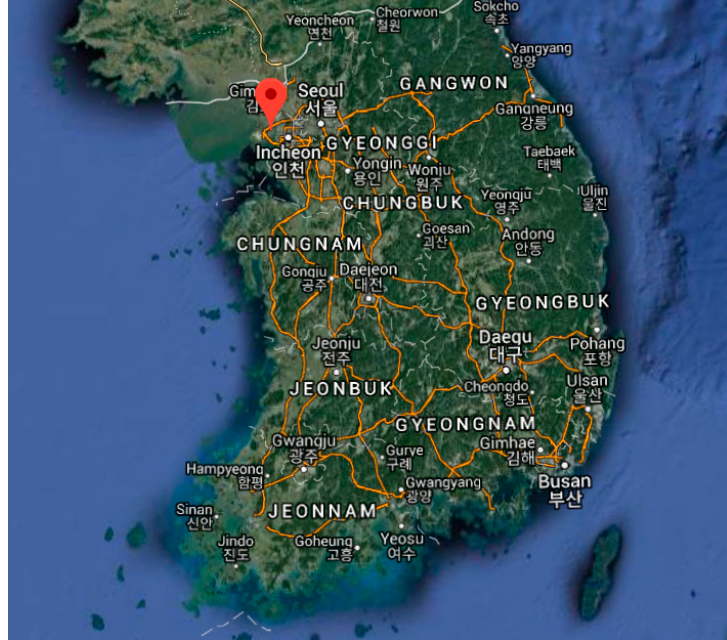
Figure 4. Location of the solar data source (Incheon) from Google Maps.